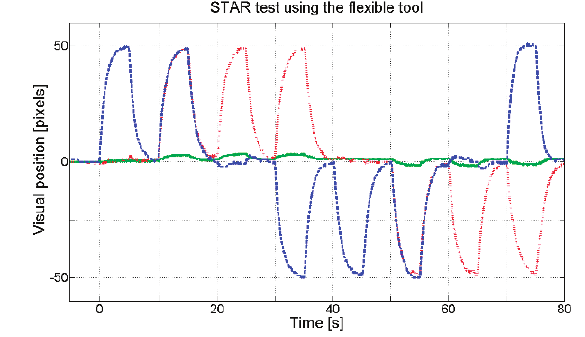
Figure 25. End-e(cid:636)ectorvisualpositionwithrespecttotimeduringtheSTARtest performed with the tool. The three components of the task space vector x v are shown: u R (blue dashed line), v R (red dotted line) and u L − u R (green solid line).